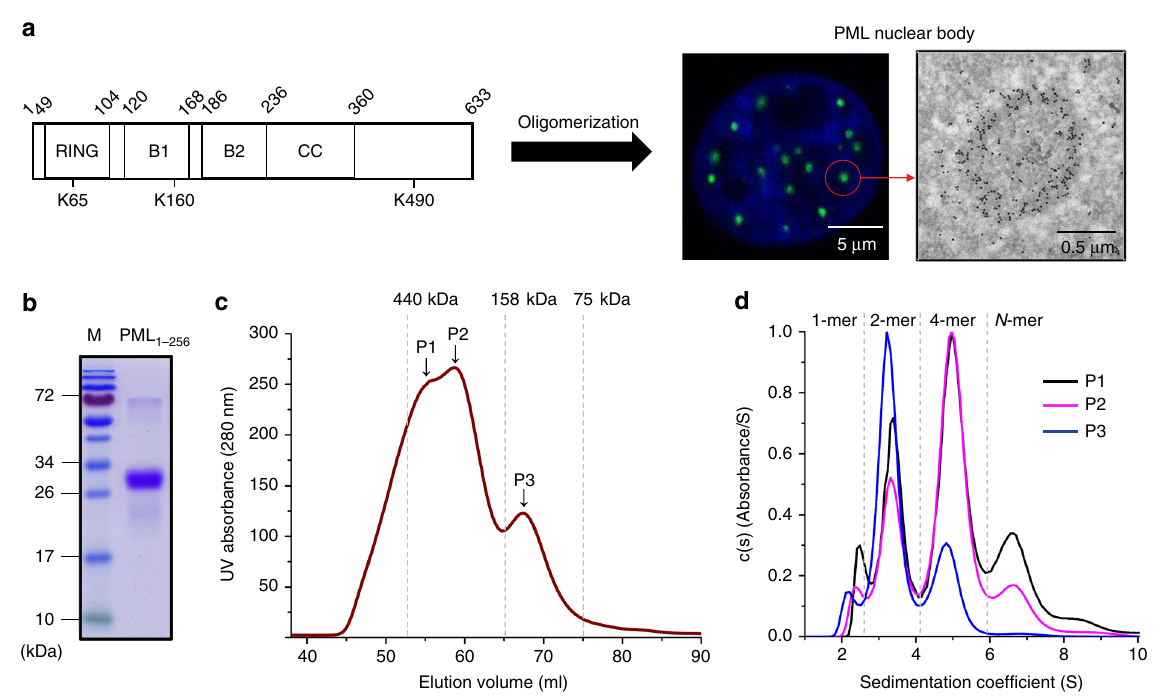
Fig. 1 Gel fi ltration (GF) and ultracentrifugation (UC) characterization of PML RBCC domain. a Oligomerization is essential to PML nuclear body (NB) biogenesis. Left panel, the domain arrangement of PML isoform IV. The starting and ending residues of the RING, B1-box, B2-box, and coiled-coil (CC) domains are annotated above the schematic diagram. The sumoylation sites K65/K160/K490 are also indicated. Middle panel, HeLa Pml − / − cells that expressing wild type GFP-PML (green). Scar bar is 5 μ m. The nucleus is stained with Hoechst (blue). Right panel, the immuno-gold electron microscopy visualization of a single PML NB (circled, middle panel), scar bar is 0.5 μ m. The black dots in this micrograph are PML speci fi c immune-gold particles. b Puri fi cation of recombinant PML RBCC 1 – 256 as monitored by SDS-PAGE. The theoretical molecular weight (MW) of PML 1 – 256 is 28 kDa. c Gel fi ltration analysis of PML 1 – 256 . The elution peaks are designated as P1 – P3, respectively. Source data are provided as a Source Data fi le. The Superdex 200